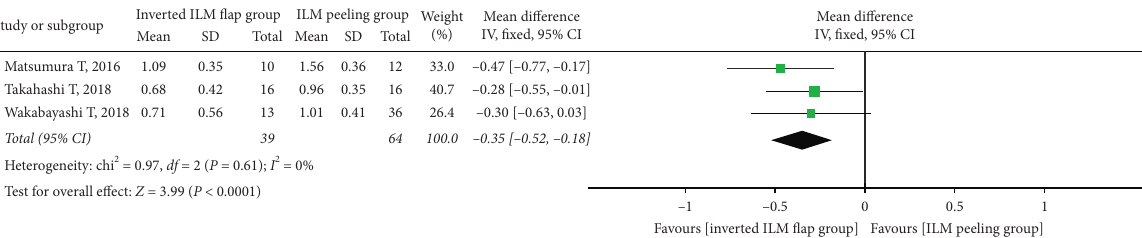
Figure 7: Forest plot comparing postoperative BCVA between inverted ILM flap and ILM peeling groups at 12 months after surgery. BCVA � best-corrected visual acuity, ILM � internal limiting membrane.